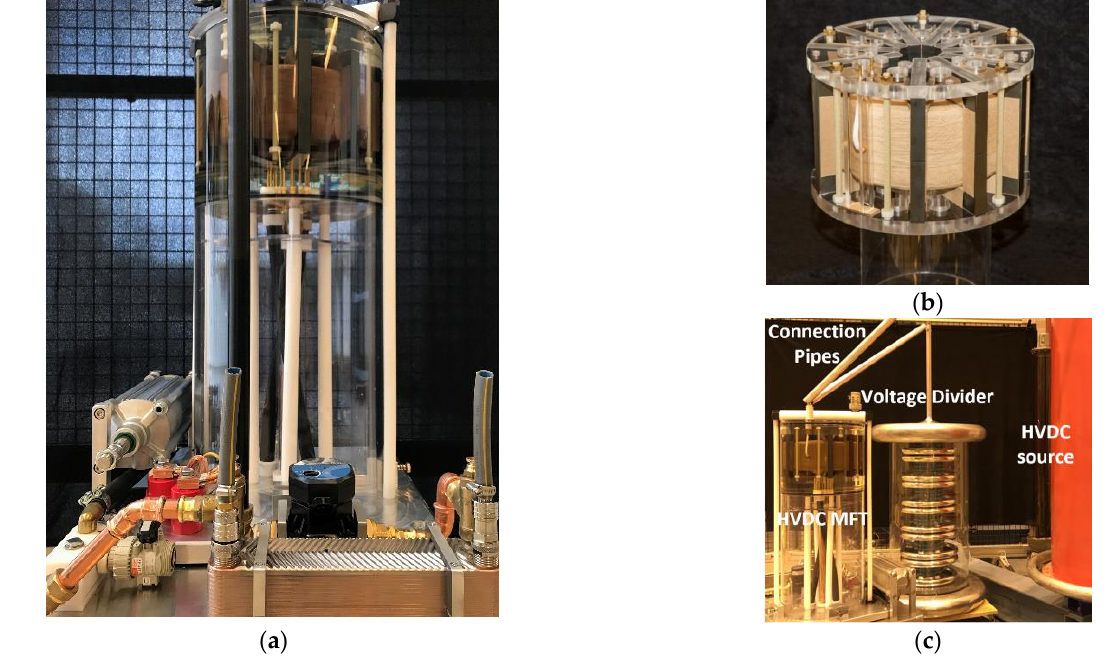
Figure 2. Manufactured prototype: ( a ) Complete transformer; ( b ) Active part; ( c ) DC insulation test setup.